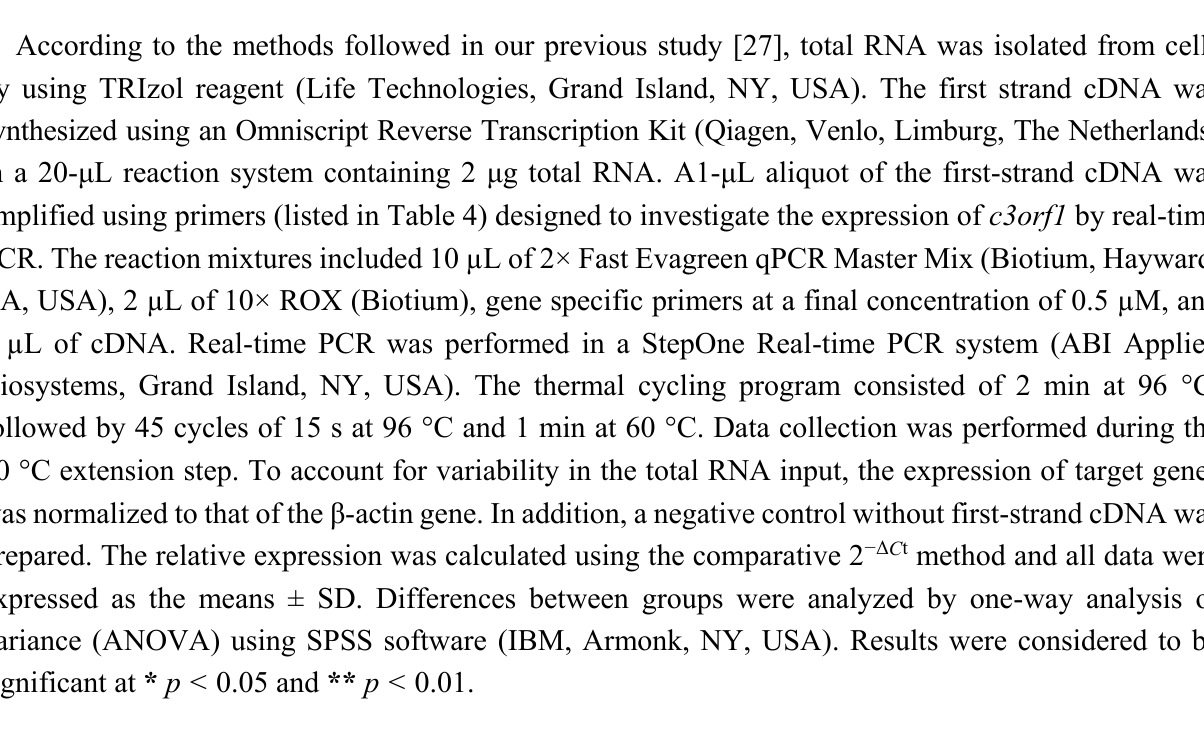
Table 4. siRNA sequences and sequences of oligonucleotides used for